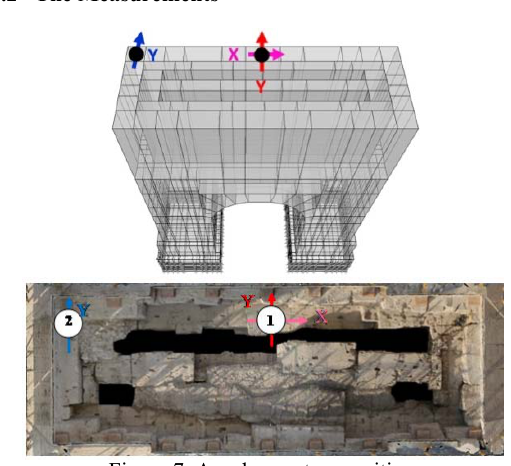
Figure 7. Accelerometers position.